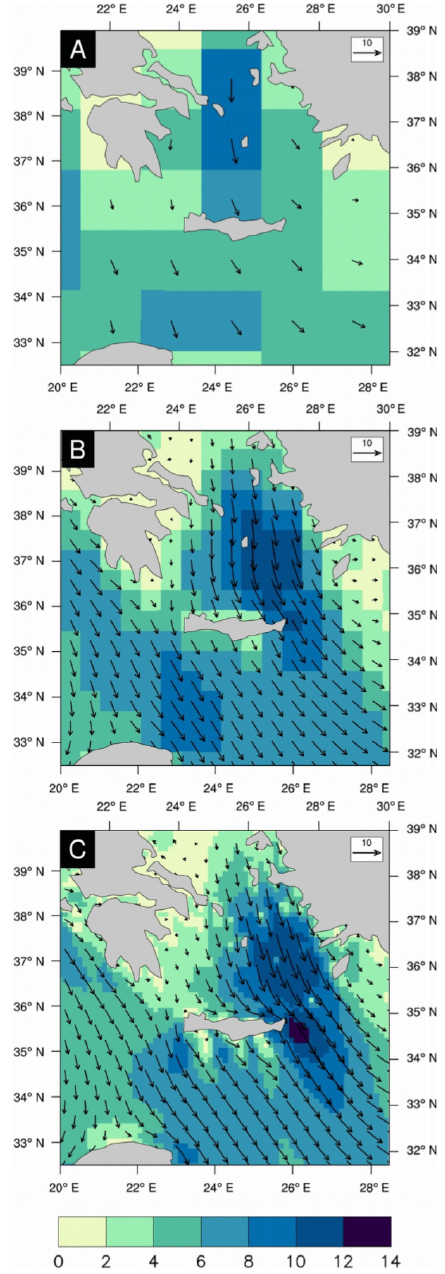
Figure 2. Daily average wind direction (arrows) and wind speed (color in ms − 1 ) on 16 August 2012 in (a) ALADIN- 150km, (b) ALADIN-50km and (c) ALADIN-12km (the so-called